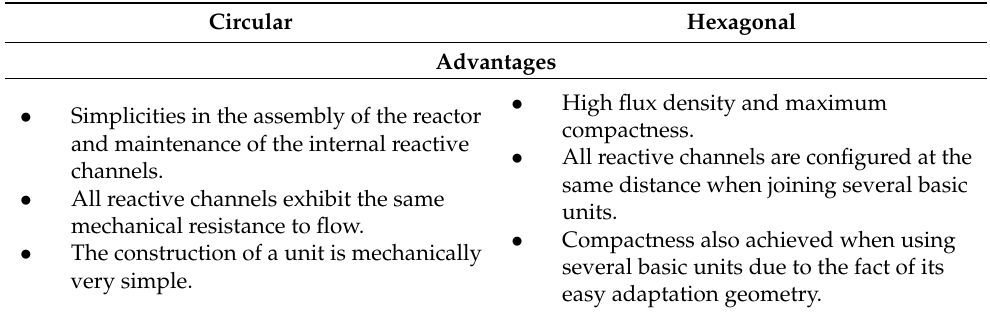
Table 4. Pros and cons of the scaled-up multi-tubular fixed-bed reactor designs simulated for CO 2 methanation